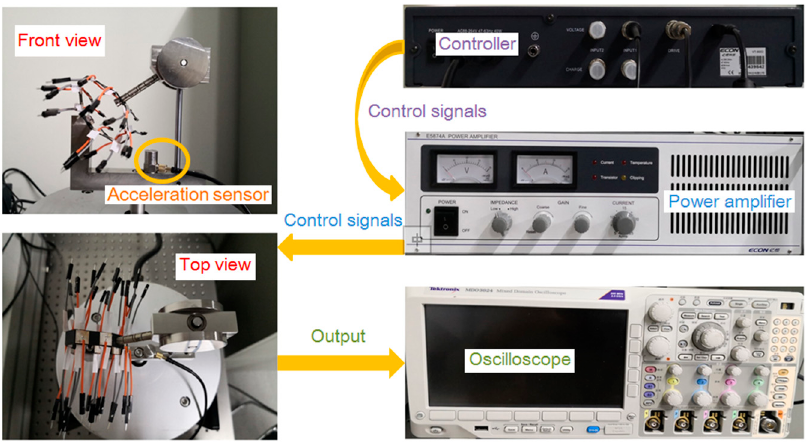
Figure 4. The fabricated prototype of the energy harvesting system. Table 1. Material properties and prototype parameters.